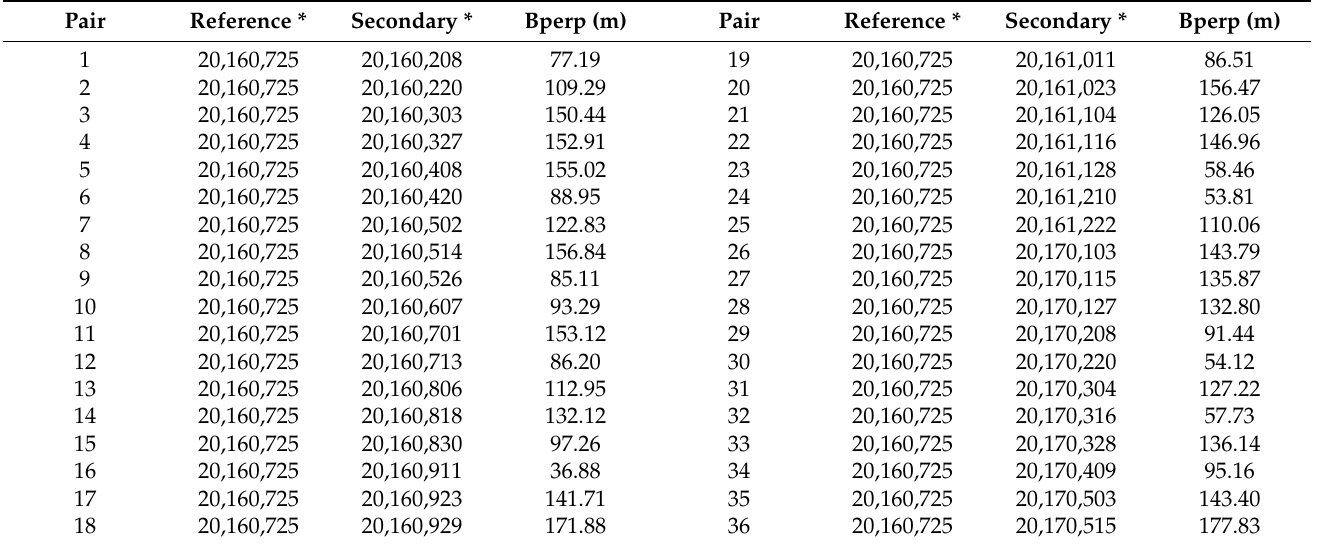
Table 1. The acquisition dates of the Reference and Secondary S1B images, perpendicular baseline (Bperp) and time interval relative to the Reference